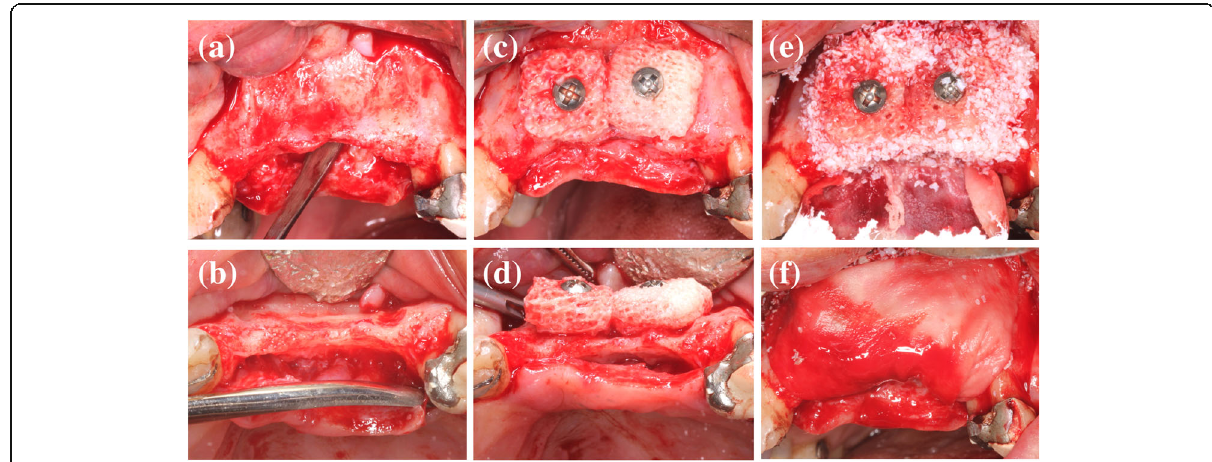
Fig. 2 Lateral bone augmentation of the alveolar crest ( a ) atrophic ridge. b Perforations and adaptation of the cortical layer. c Shaping, pre- wetting and fixation of CCXBB with titanium screws. d Horizontal contour and peripheral gap between CCXBB and bone layer. e Outlying DBBM filling. f CM stabilized with pins